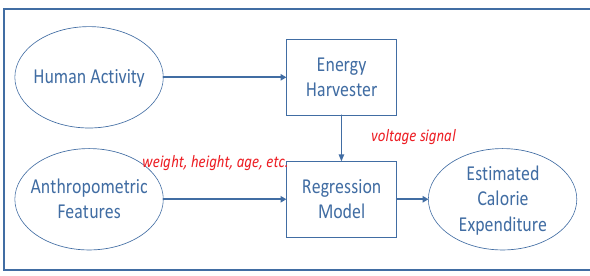
Figure 4: Architecture of the PEH based calorie ex- penditure